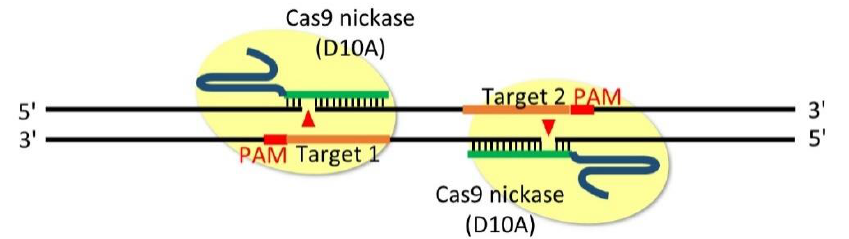
Figure 4. Double-nicking method that can introduce insertion/deletion (indel) mutations between a pair of single-guide RNAs (sgRNAs). The Cas9 D10A nickase generates a nick (arrowheads) in the strand complementary to the sgRNAs. The orange line denotes the pair of sgRNAs targeting opposite strands of the genome, and red denotes the PAM sequences. PAM sequences with an outward orientation generate 5′ overhangs, which are necessary for the robust induction of indel mutations.